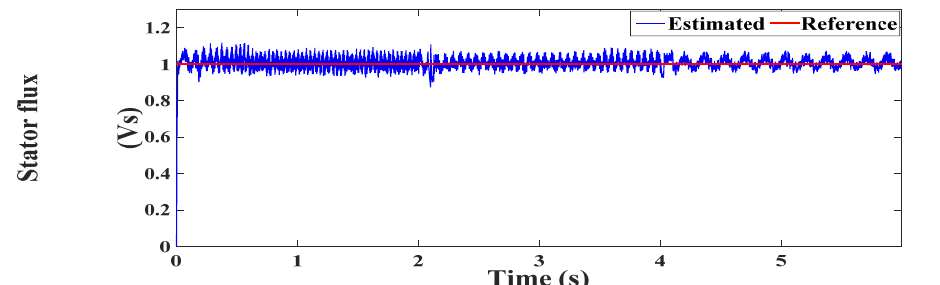
Figure 9. Torque profile under PTC approach (Nm).